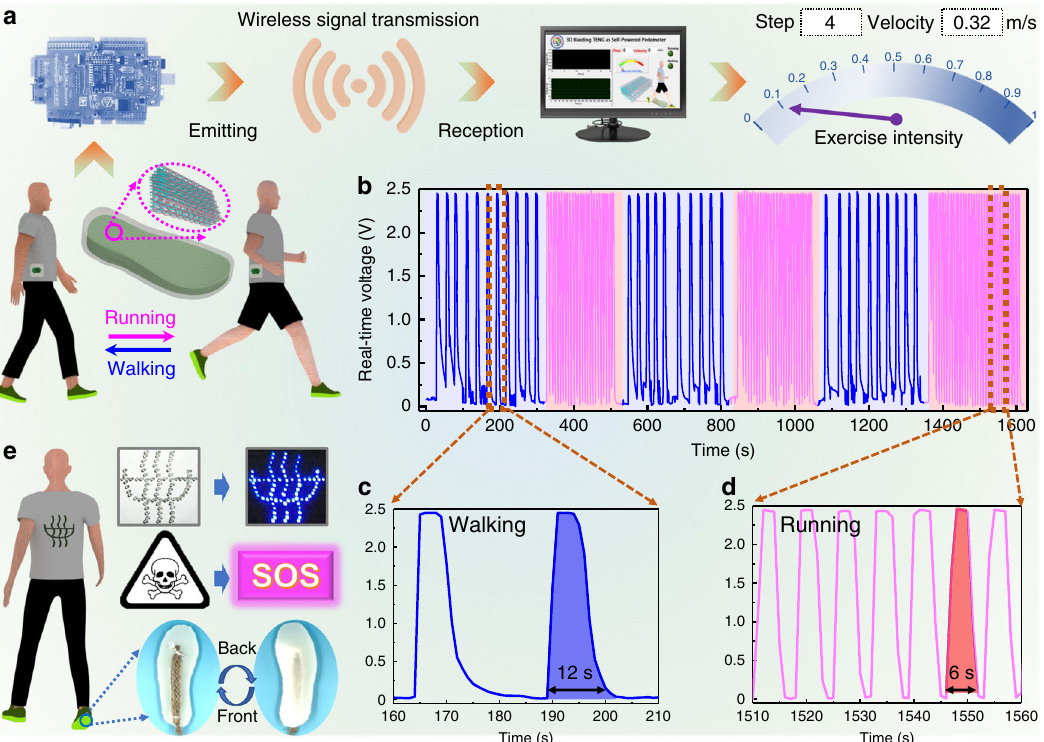
Fig. 5 An intelligent footwear system for human motion monitoring and remote emergency rescue. a Flowchart of the intelligent footwear system for real-time human motion monitoring, including a signal acquisition system, a wireless transmission module, a data processing program, and a software output interface. b Real-time voltage signals of the intelligent footwear system during the alternating process of walking (blue) and running (magenta). c , d Enlarged voltage signals of walking ( c ) and running ( d ) states, in which the interval period of each step is 12 s and 6 s, respectively. e Demonstrations of the intelligent footwear system in night safety protection and remote emergency rescue. Source data are provided as a Source data fi